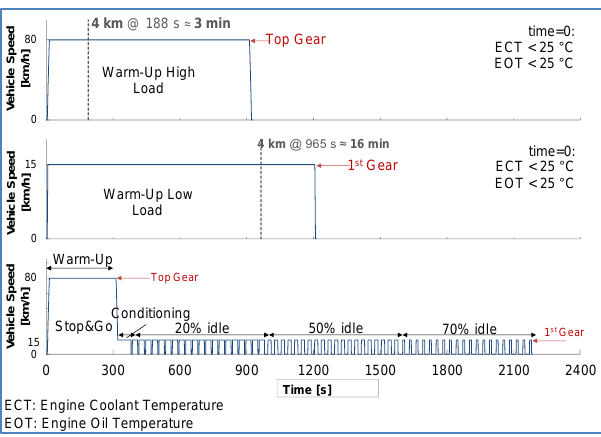
Fig. 12. Driving cycles for reproduction of warm-up and stop&go proce- dures on chassis dynamometer